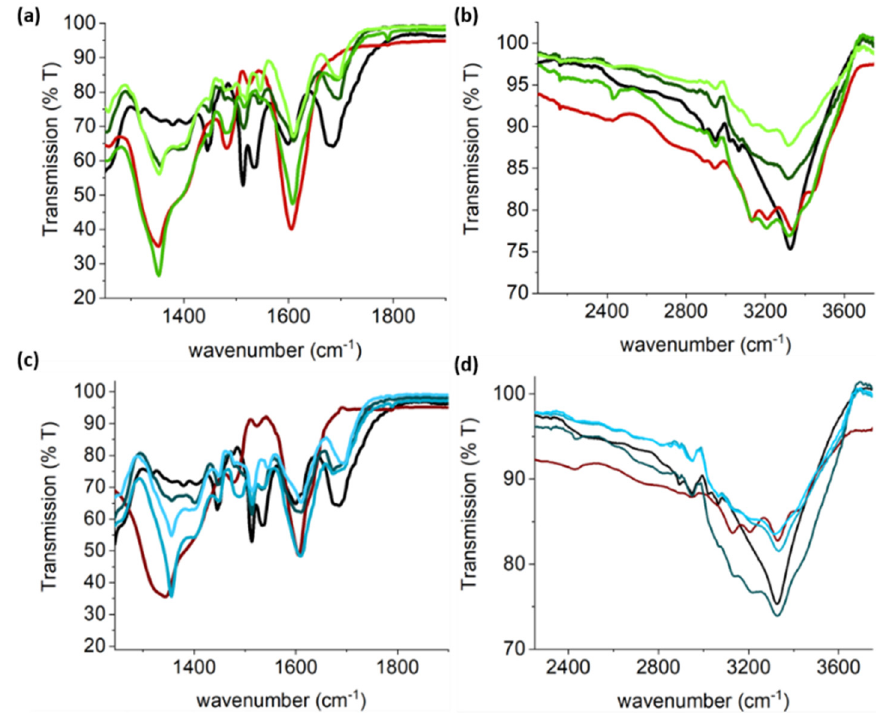
Figure 4. FTIR spectra of lyophilised multicomponent hydrogels. ( a , b ) 1:1 Ag:GMP molar ratio and varying FY concentrations, samples A ( ― ), B ( ― ), and C ( ― ), whereas ( c , d ) 2:1 Ag:GMP stoichiometry and FY varying concentrations; samples D ( ― ), E ( ― ), and F ( ― ).